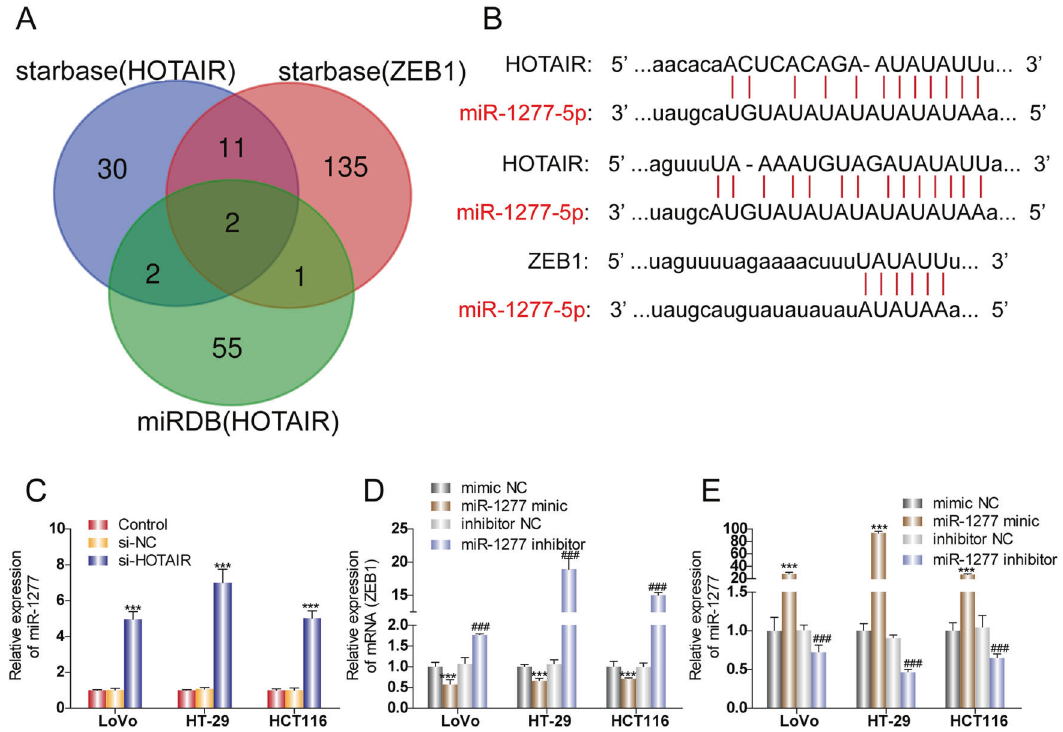
Fig. 5 MiR-1277-5p is involved in the cross-talk between HOTAIR and ZEB1. A Veen diagram of candidate miRNAs. B Schematic illustration of the predicted miRNA (miR-1277-5p/miR-326) binding sites in HOTAIR and ZEB1 3'-UTR. C The relative expression level of miR-1277-5p after knocking down HOTAIR. D The relative expression level of ZEB1 after overexpressing miR-1277-5p or inhibiting miR-1277-5p. E The relative expression level of miR-1277-5p was con fi rmed after transfection of miR-1277 mimic, miR-1277-5p inhibitor, or corresponding negative control, respectively. *** p < 0.001, ### p < 0.001.